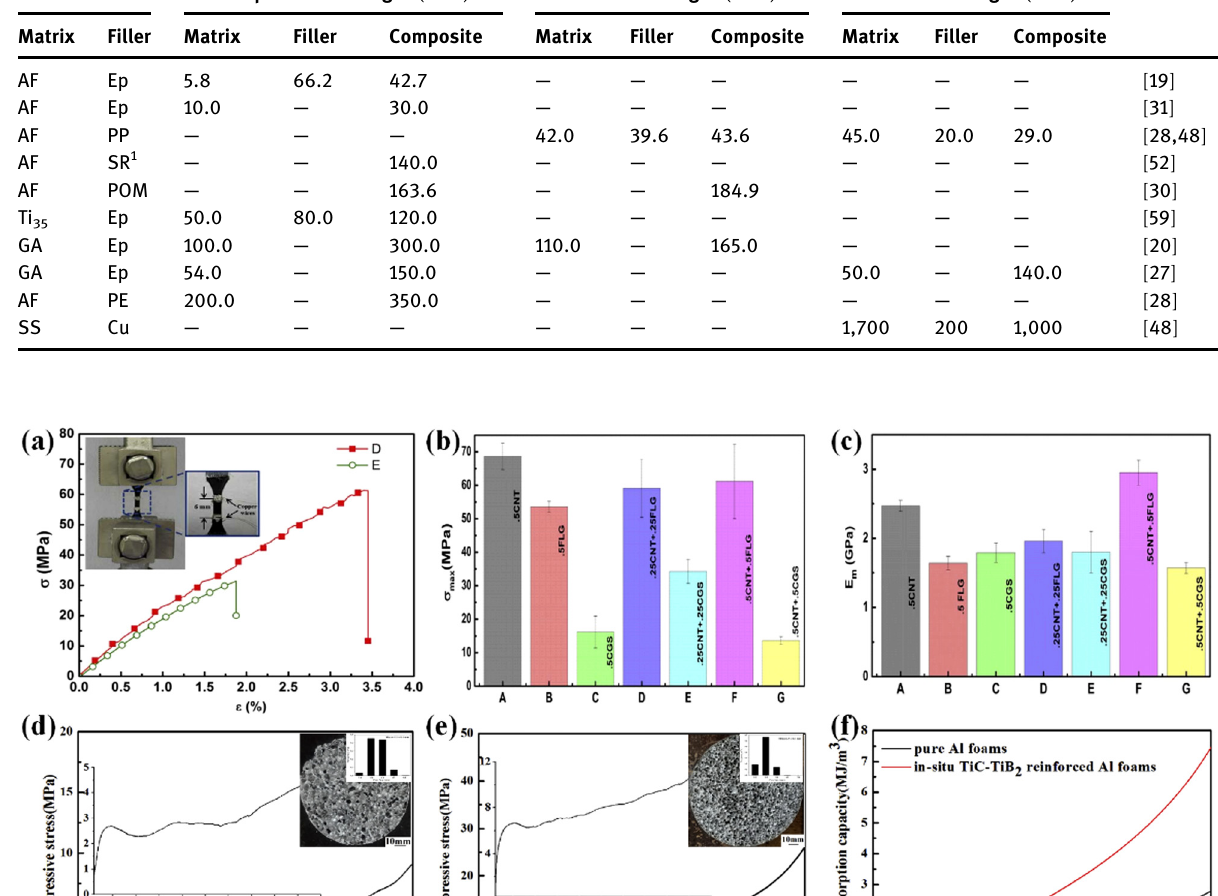
Table 1: Mechanical properties of di ff erent 3D - NTSCs Materials